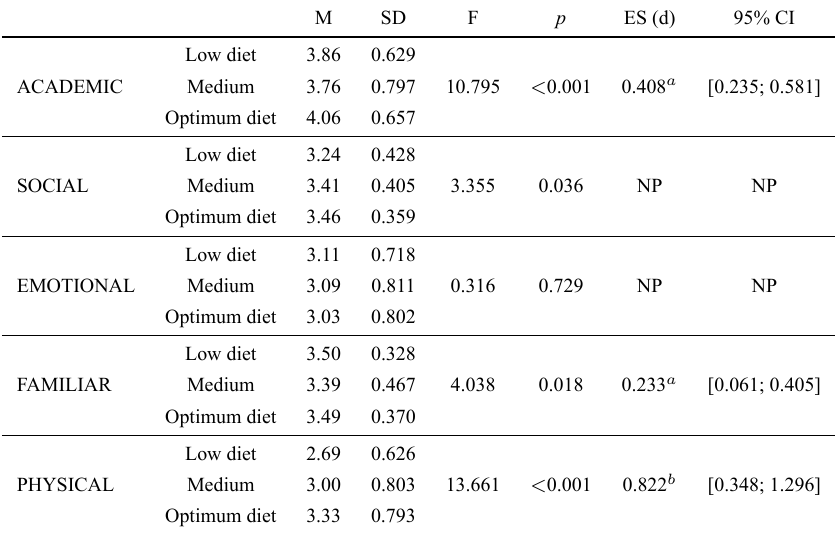
Table 4. Relationship between self-concept and adherence to Mediterranean diet.